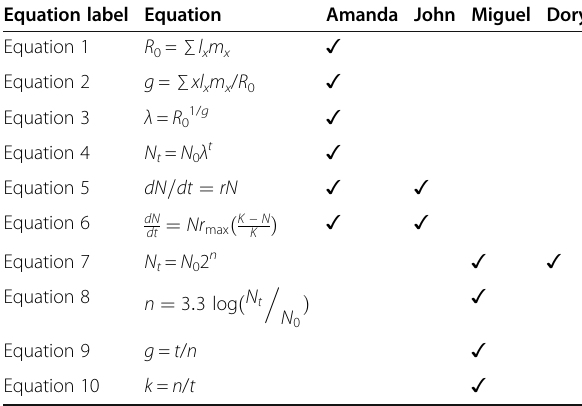
Table 3 Mathematical equations used by instructors Equation label